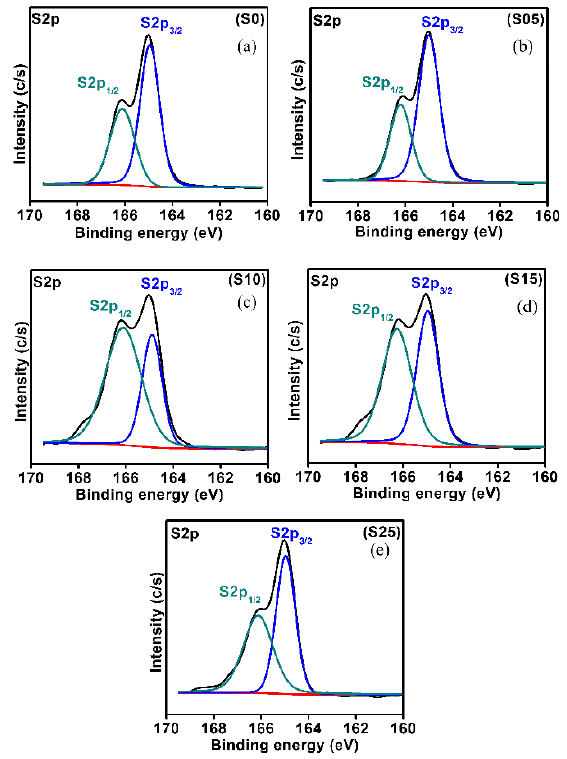
Figure 7. Chemical state analysis of S2p for the CdSe 1 − x S x nanostructures with different content of sulfur. ( a ) x = 0.0 (S0 sample); ( b ) x = 0.05 (S05 sample); ( c ) x = 0.1 (S10 sample); ( d ) x = 0.15 (S15 sample); ( e ) x = 0.25 (S25 sample).